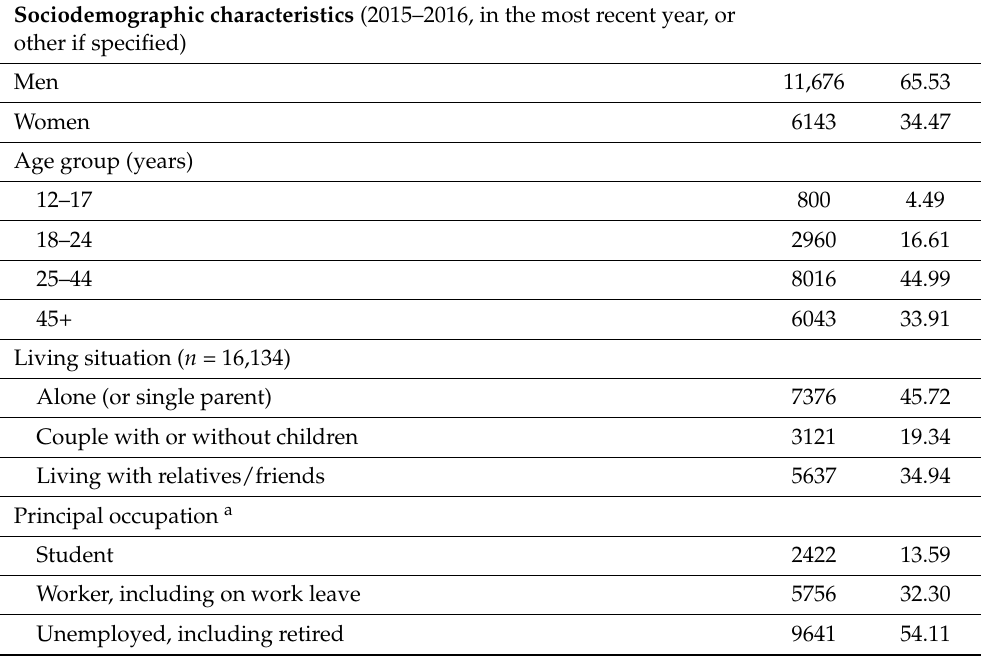
Table 1. Characteristics of patients using addiction treatment centers ( n = 17,819, or other if specified). Sociodemographic characteristics (2015–2016, in the most recent year,